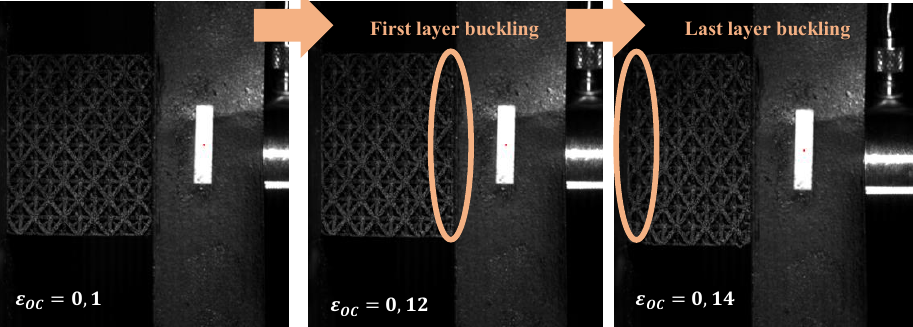
Fig. 6. OC cell : local buckling occurs in both first and last layers of RVEs